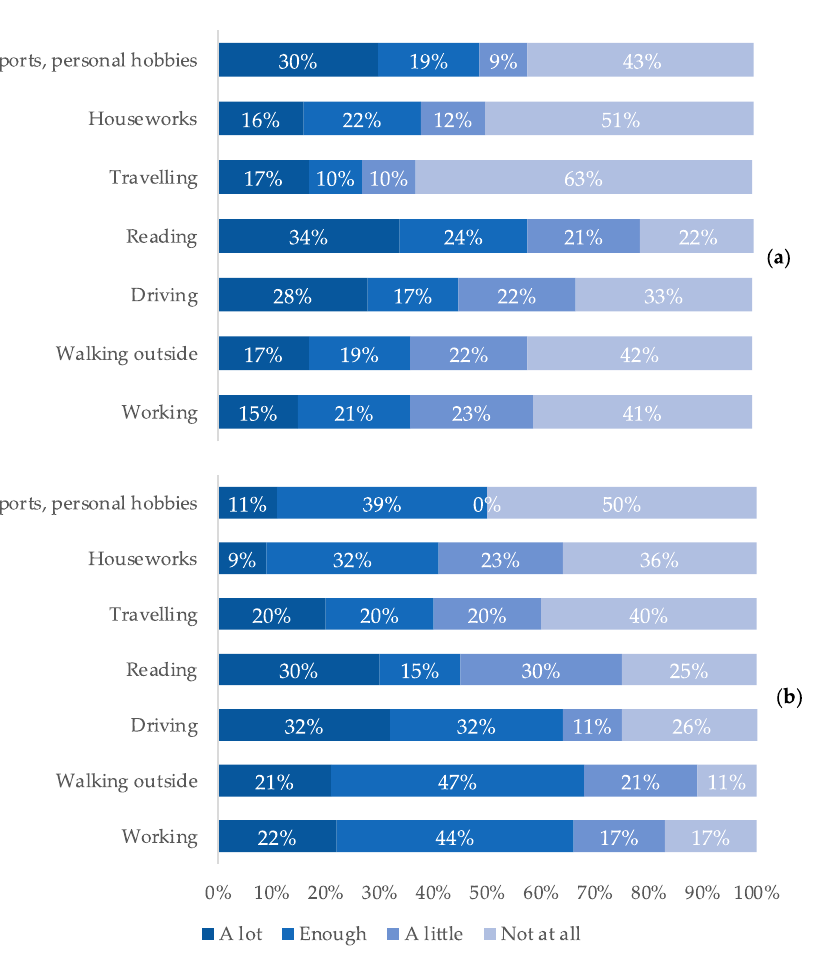
Figure 2. Difference in the perceptions of patients ( a ) and caregivers ( b ) regarding the limitations of affected patients in daily activities.